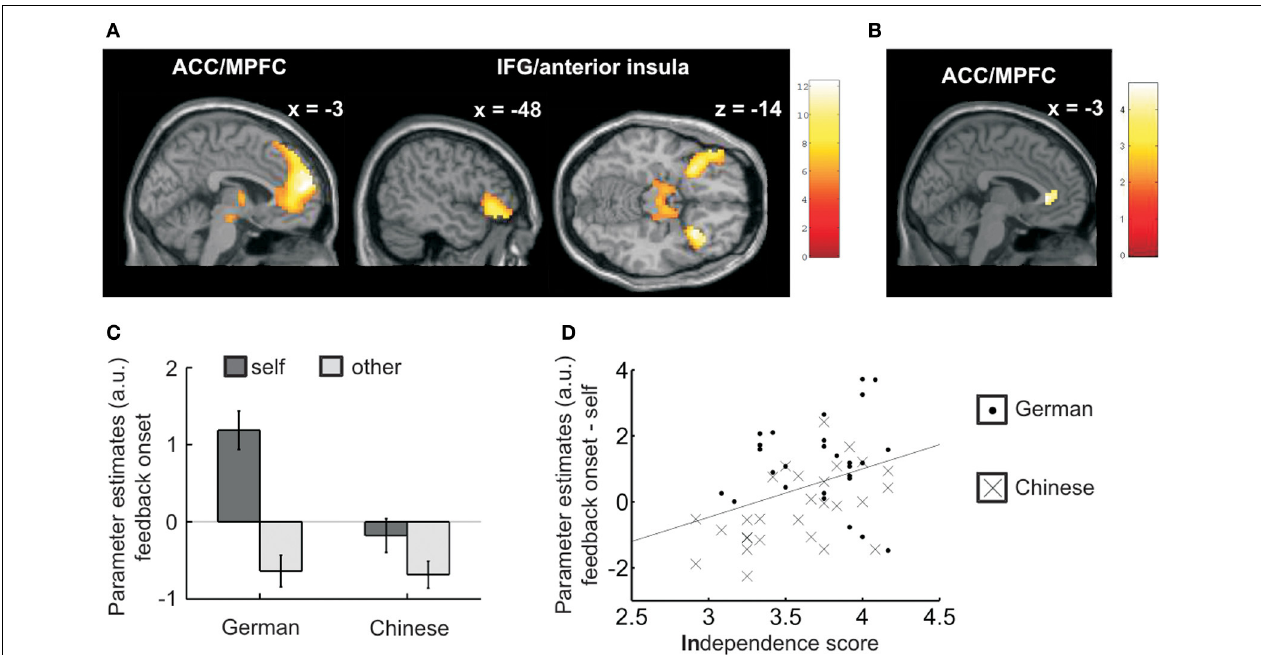
FIGURE 3 | fMRI results—cultural differences in BOLD signals when receiving feedback. (A) When participants received social feedback, ACC/MPFC and IFG/anterior insula showed a main effect for feedback target (self > other) across all participants ( p < 0 . 05 FWE corrected, cluster size > 15; Table 3 ). (B) When participants received social feedback, activity in the ACC/MPFC differed between Germans and Chinese. There was a culture (German/Chinese) by feedback target (self/other) interaction ( p < 0 . 05 small volume corrected within the main effect shown in (A) ; initial contrast